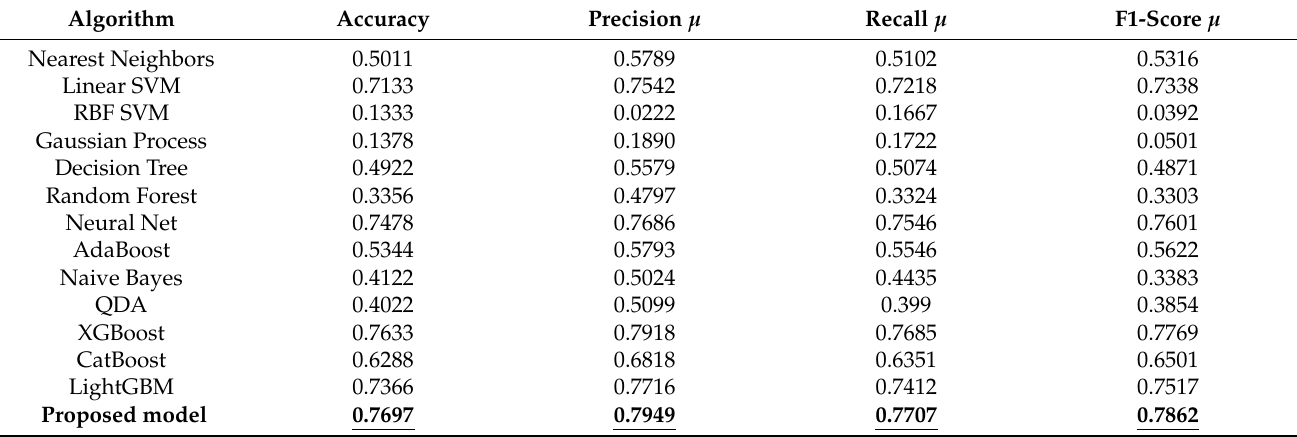
Table 4. Rice seed variety classification results.